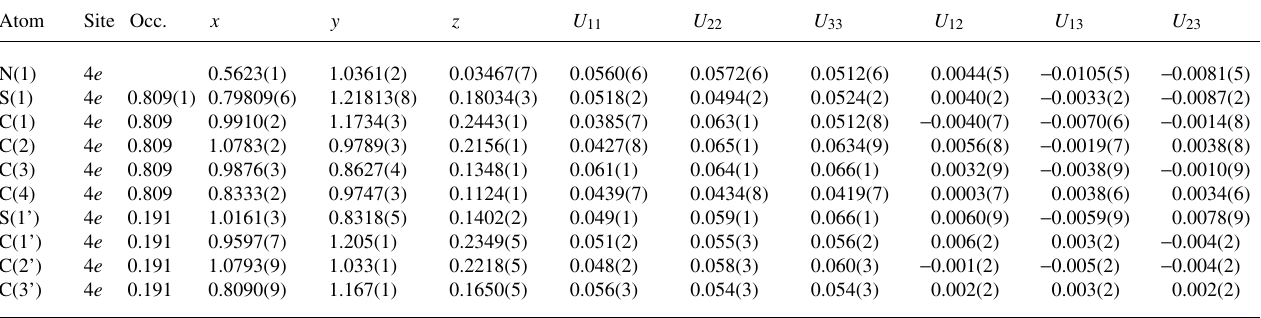
Table 3. Atomic coordinates and displacement parameters (in Å 2 ) . Atom Site